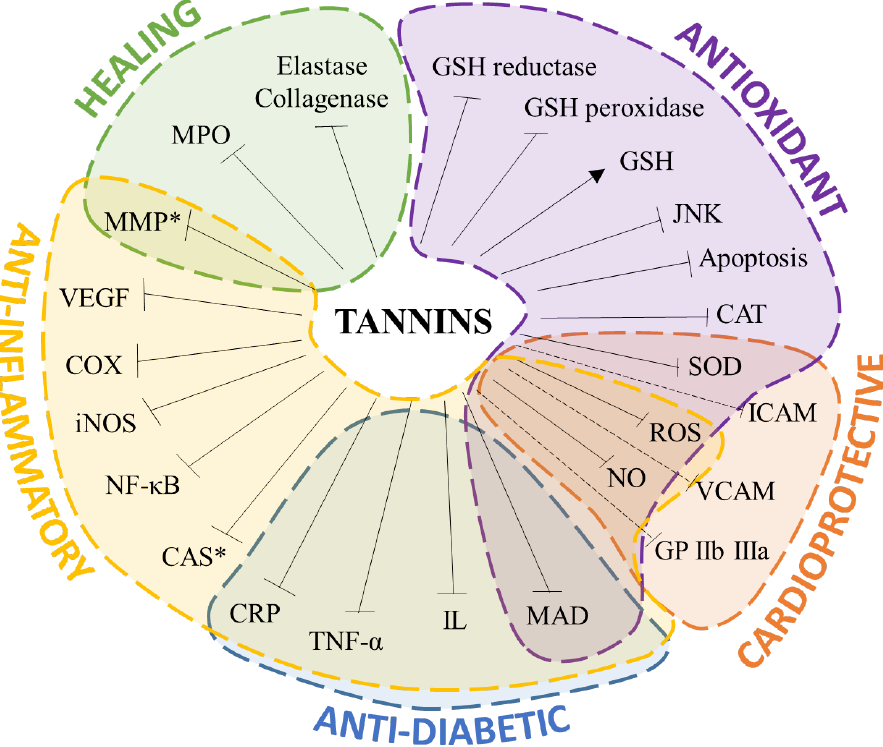
Figure 2. Visual representation of the suggested mechanisms involved in the biological properties of tannins. Lines show decrease in or inhibition of biomarkers, whereas arrows show an increase in or promotion of reduced glutathione (GSH). (* = antioxidant activity; MAD: malondialdehyde; IL: interleukin; TNF- α : tumor necrosis factor- α ; CRP: c-reactive protein; CAS: caspase; NF- κ B: nuclear factor- κ B; iNOS: nitric oxide synthase; COX: cyclooxygenase; VEGF: vascular endothelial growth factor; MMP: matrix metalloproteinase; JNK: C-Jun N-terminal kinase; MPO: myeloperoxidase; CAT: catalase; SOD: superoxide dismutase; ROS: reactive oxygen species; NO: nitric oxide; VCAM: vascular cell adhesion protein; ICAM: intercellular adhesion molecule; GP IIb IIIa: glycoprotein IIb/IIIa).2.2. Anti-Inflammatory